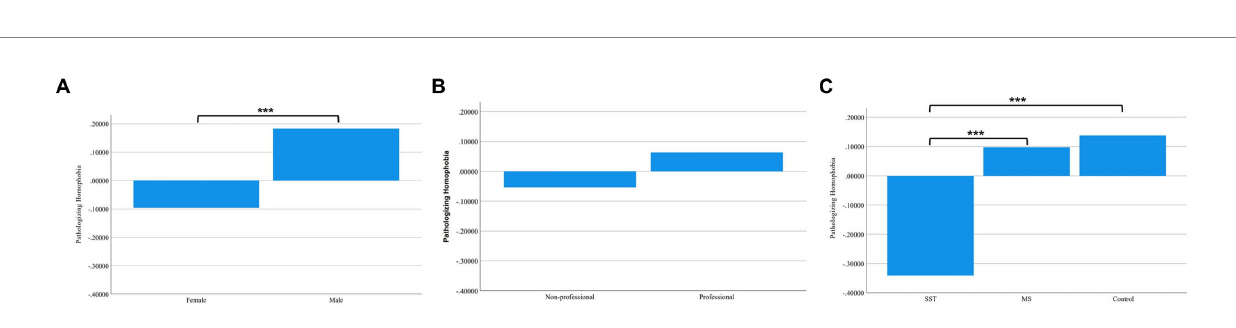
FIGURE 2 Group Differences in Oppressing Homophobia. (A) Differences between Female and Male. (B) Differences between Non-professionals and Professionals. (C) Differences among Sexual Strategies Theory Group, Minority Stress Group, and Control